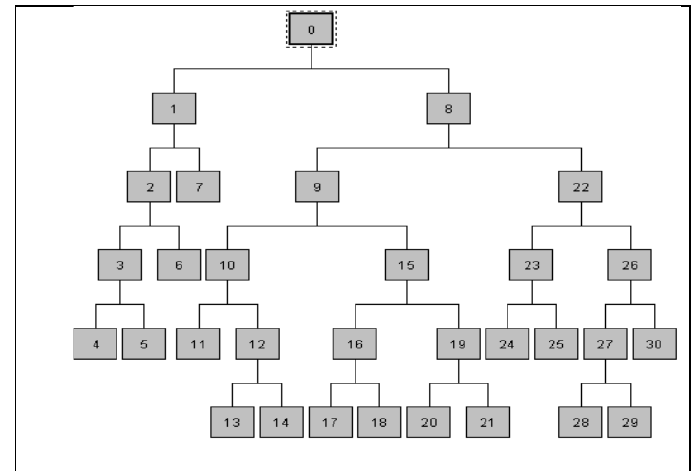
Fig. 7. All nodes of C&RT decision tree (developed by the